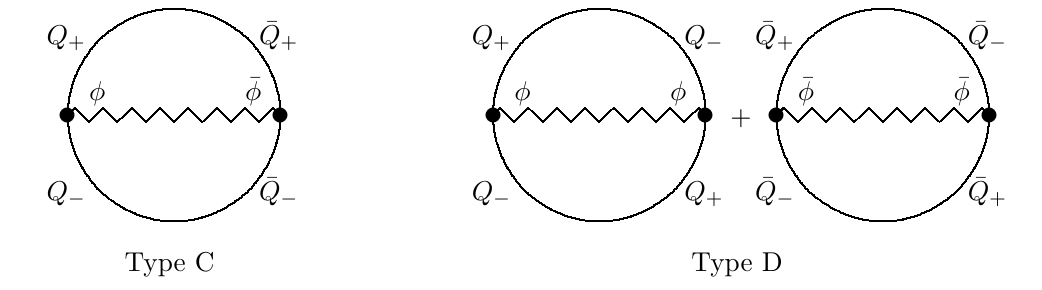
Figure 2 . Two-loop supergraphs in N = (4 ; 4) SQED which involve propagators h (cid:30) (cid:22) (cid:30) i , h (cid:30)(cid:30) i and h (cid:22) (cid:30) (cid:22) (cid:30) i .